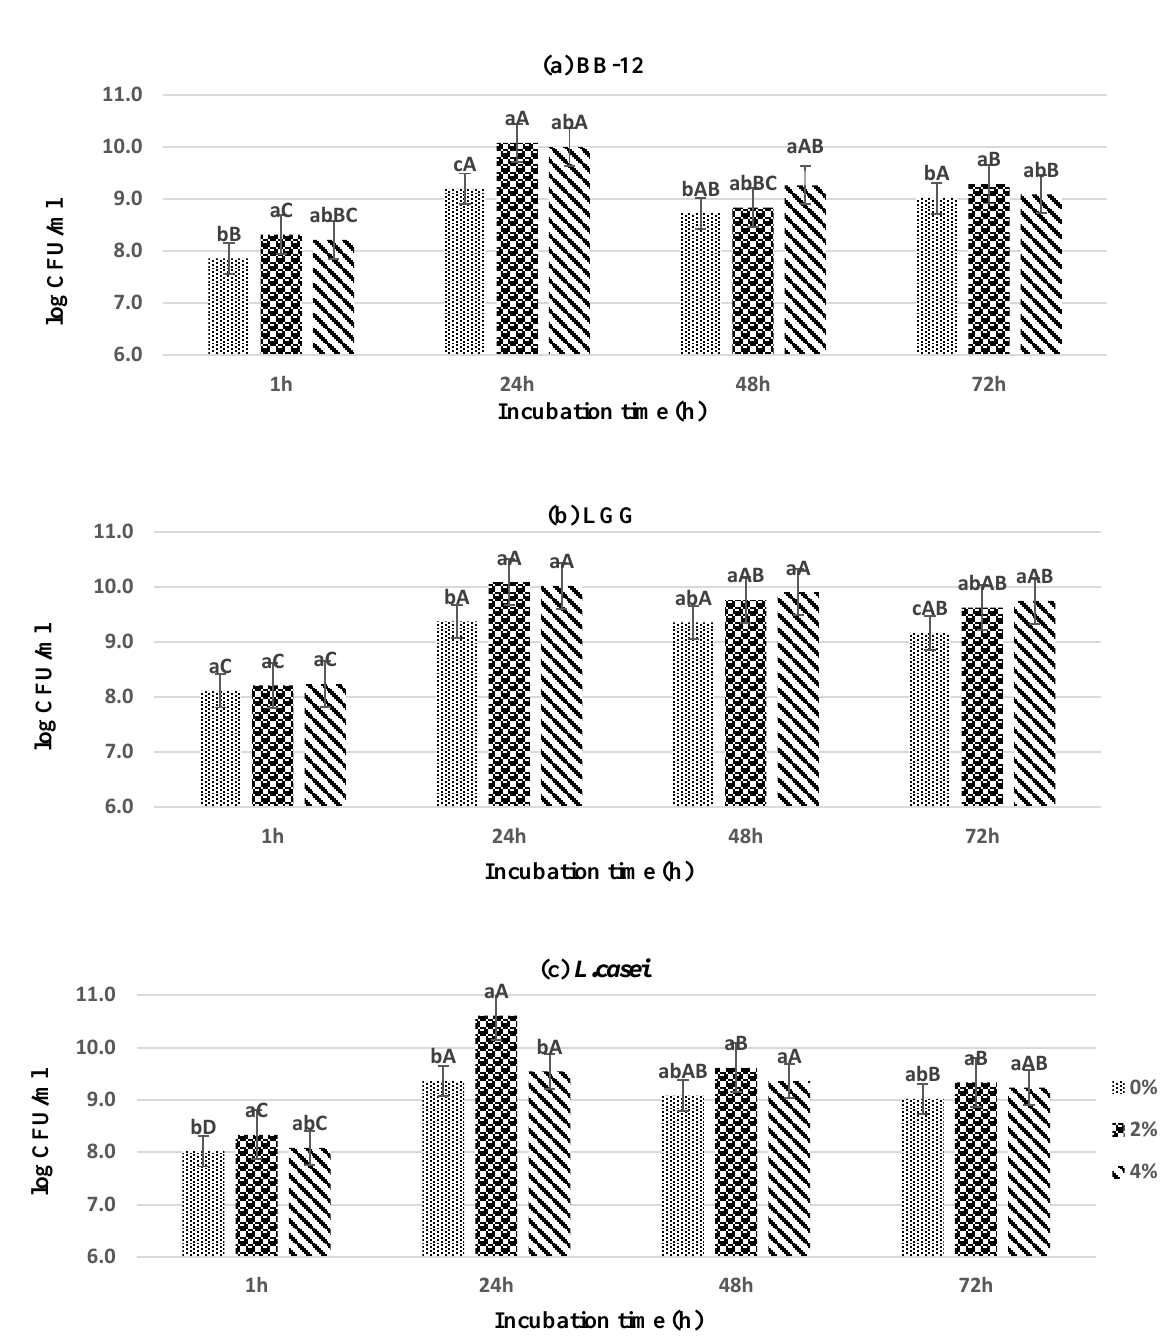
Figure 2. Prebiotic effects of different concentrations of banana peel powder (BPP) on the number (log CFU/mL) of tested individual probiotic bacteria; Bifidobacterium animalis subsp. Lactis BB-12 ( a ), Lactobacillus rhamnosus LGG ( b ) and L. casei ( c ) during 72 h of anaerobic incubation. Different lowercase letters within each incubation time and probiotic strain indicate significant difference ( p < 0.05) based on the concentration of FPP (0%, 2%, 4%) within same incubation time points and similar probiotic strain. Various uppercase letters indicate significant differences within the same concentrations at different incubation time points. Data represent mean values ± standard error ( n = 4).